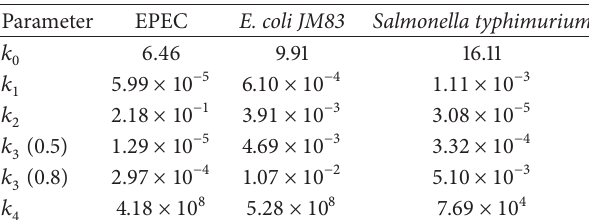
Table 3: Obtained parameter values by fitting of EPEC, E.